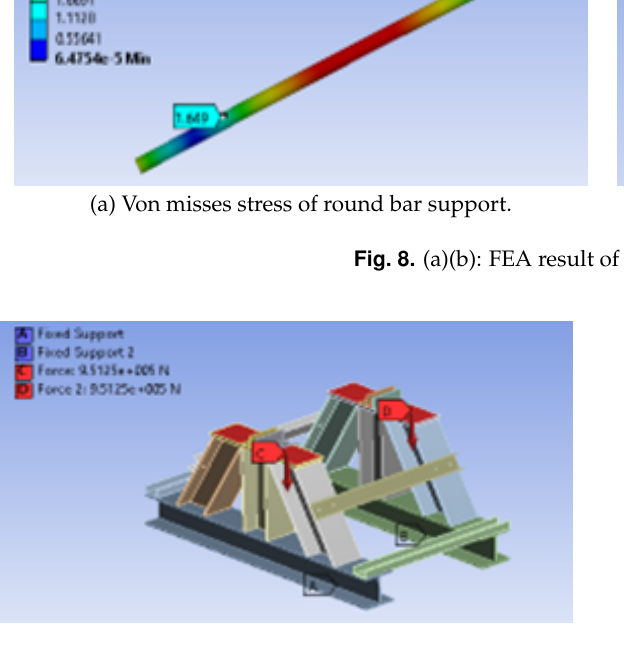
Fig. 9. Test rig frame boundary